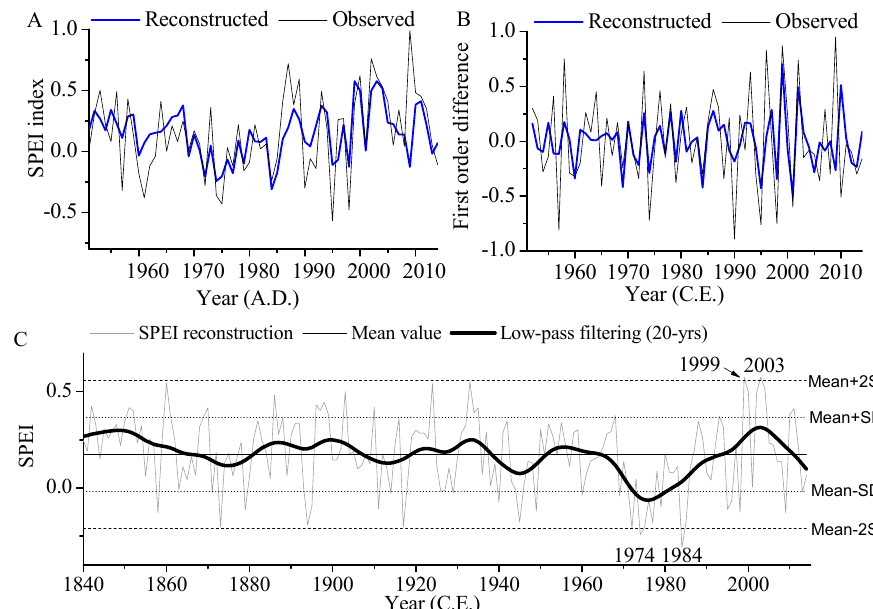
Figure 4. Reconstructed SPEI variability of the Chu River Basin. ( A ) Comparison of the reconstructed SPEI (blue line) and the SPEI recorded in grid from CRU (black line) during the common period 1951–2014. ( B ) Comparison of the first differences (year-to-year changes) between the reconstruction (blue line) and the SPEI grid (black line). ( C ) Reconstructed SPEI from the previous July to the current June for the Chu River Basin since 1840 C.E. (gray line). The bold black line shows the data smoothed with a 20-years low-pass filter to emphasize the long-term fluctuations. The solid horizontal line represents the long-term mean for the period 1840–2014; the dashed horizontal lines represent the mean value ± 1 σ and the dotted horizontal lines represent the mean value ± 2 σ